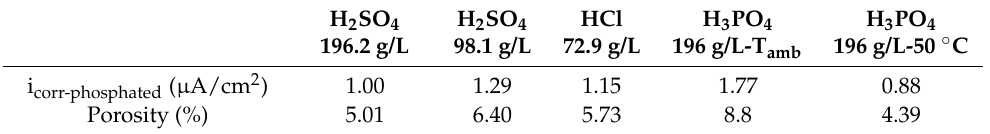
Figure 2. Polarization curves for the phosphated specimens obtained in a 0.1 M Na 2 SO 4 solution: ( a ) after the pickling with the conventional acids; ( b ) after the pickling with citric acid. Potential values are referred to a Hg/Hg 2 SO 4 electrode. Table 5. Average corrosion data obtained from the polarization curves performed in 0.1 M Na 2 SO 4 .